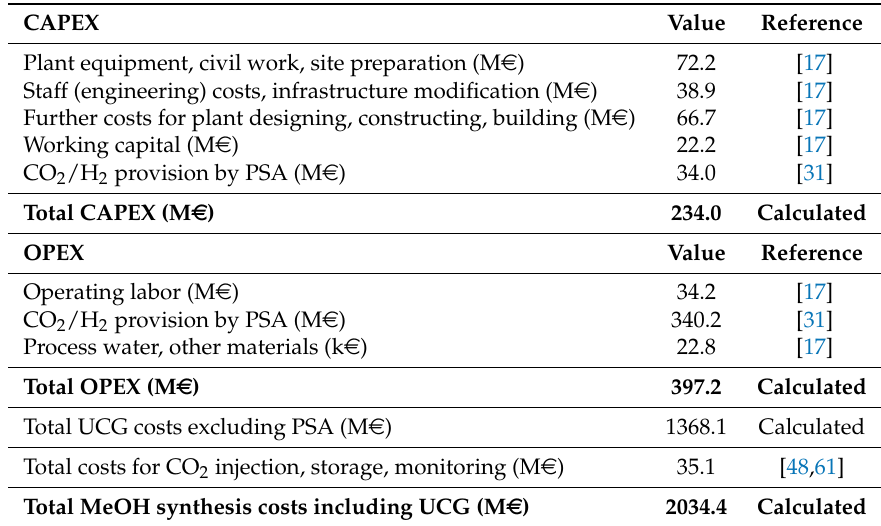
Table 12. Cost positions for methanol production process stages, combined as UCG-based methanol production costs for a 20-year operational lifetime (plant size of about 490 kt/year).